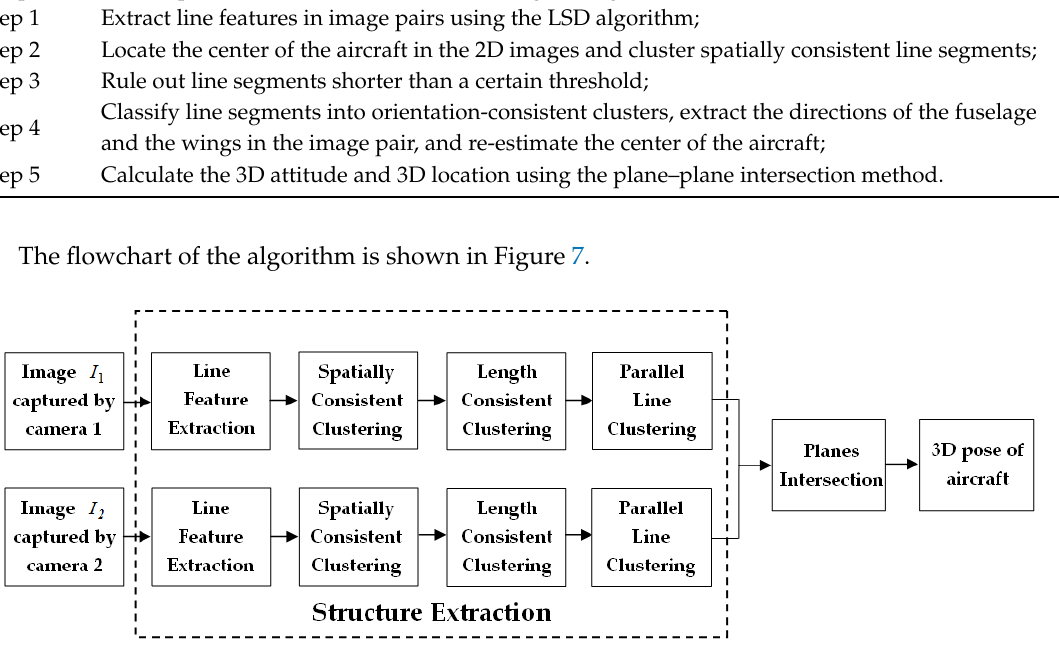
Figure 7. The flowchart of our pose estimation algorithm.